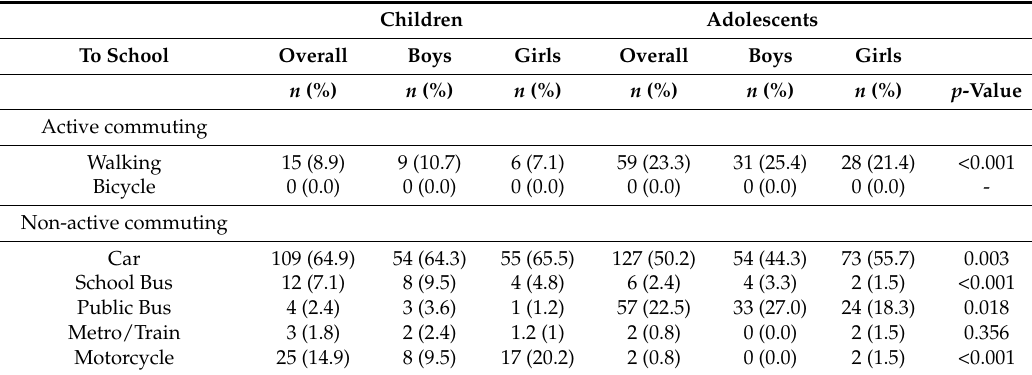
Table 2. Mode of commuting to and from school by sex in children and